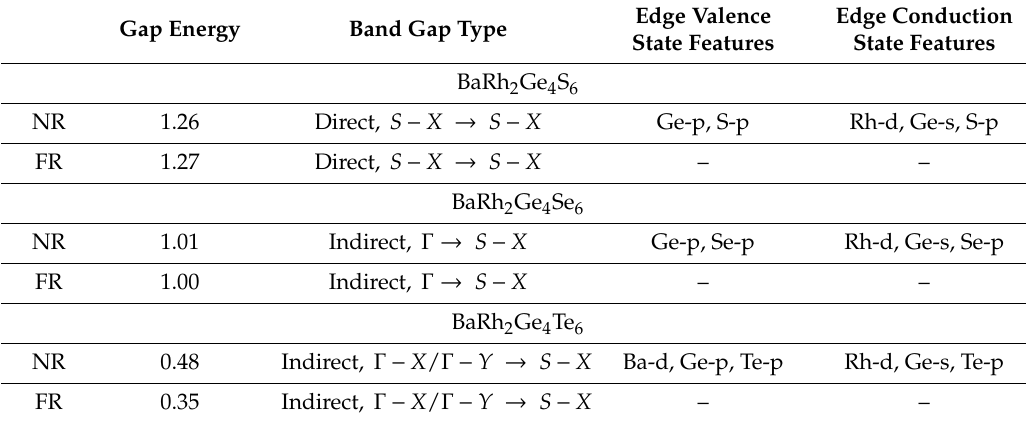
Table 2. Electronic band characteristics of the BaRh 2 Ge 4 X 6 compounds. NR: non-relativistic; FR: full-relativistic. Gap energies in